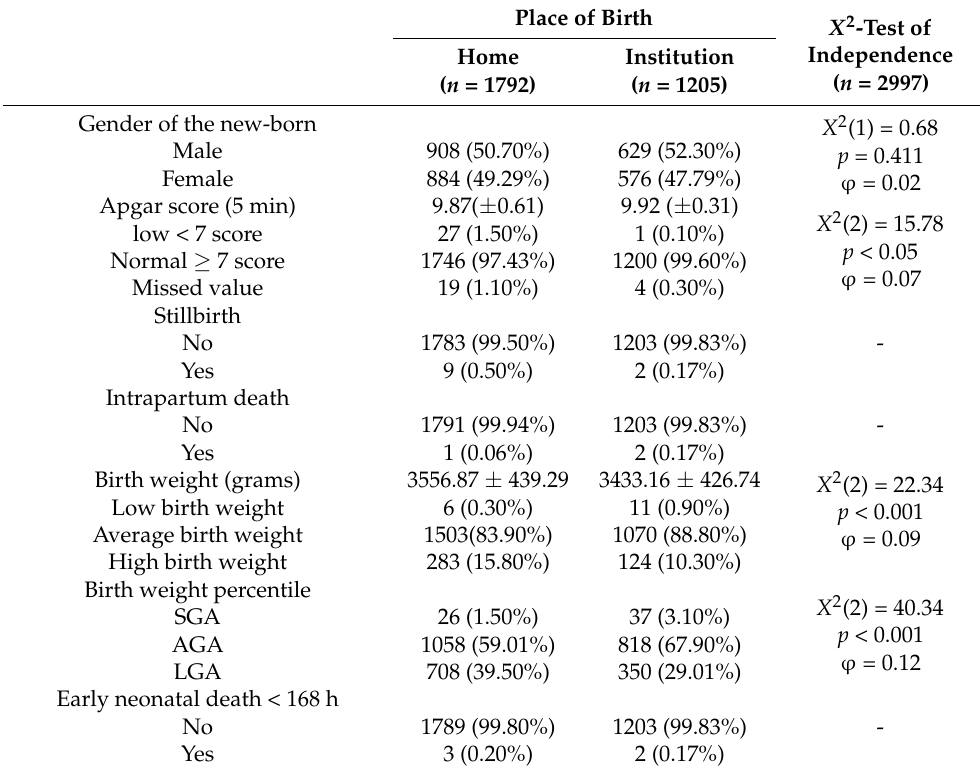
Table 2. Characteristics and outcomes of the newborns from mothers who experienced home birth and institutional births in Hungary, 2012–2020.